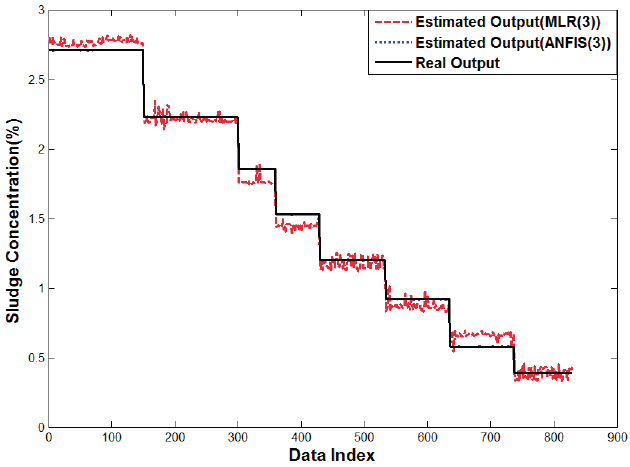
Figure 15. Performance curve of the one sensor case and Method 1.